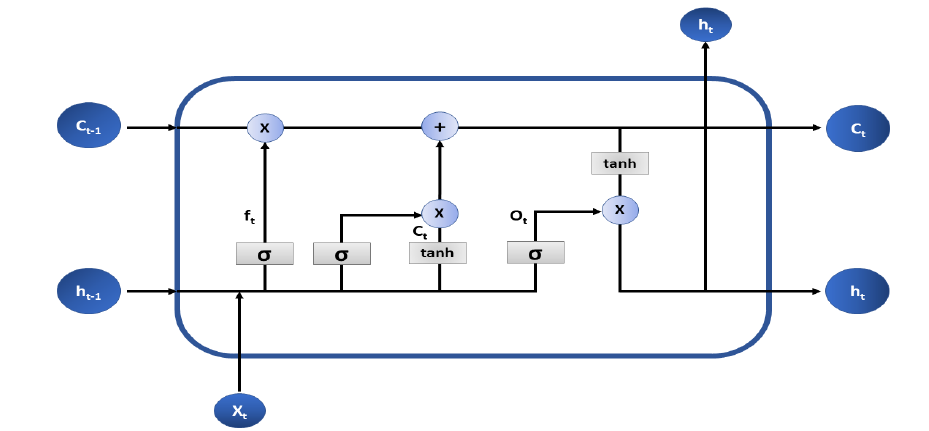
Figure 3. Architecture of the LSTM